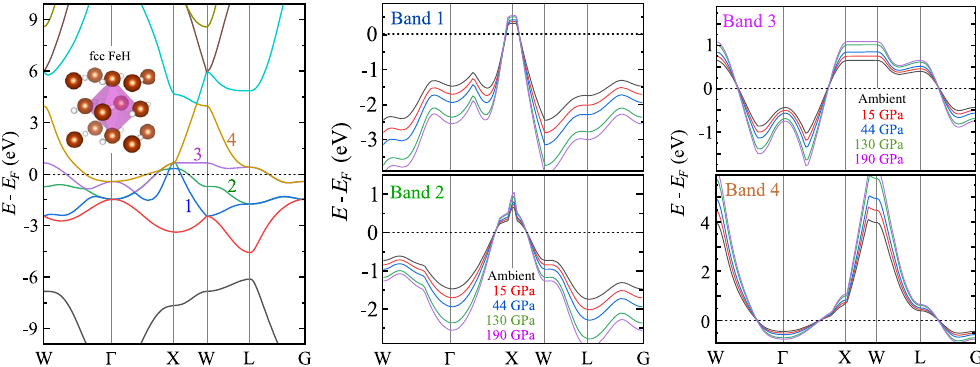
FIG. 4. Calculated band structure of fcc FeH. The left panel shows the band structure at ambient pressure, the two right panels the pressure evolution of four bands crossing the Fermi energy ( E